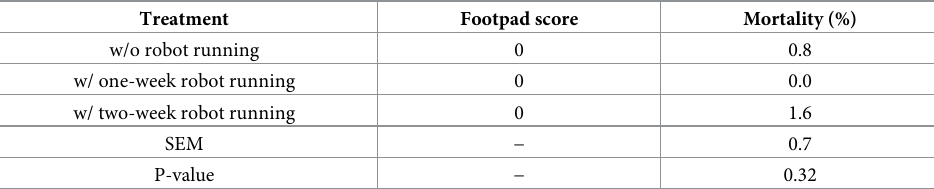
Table 4. Footpad score and mortality.